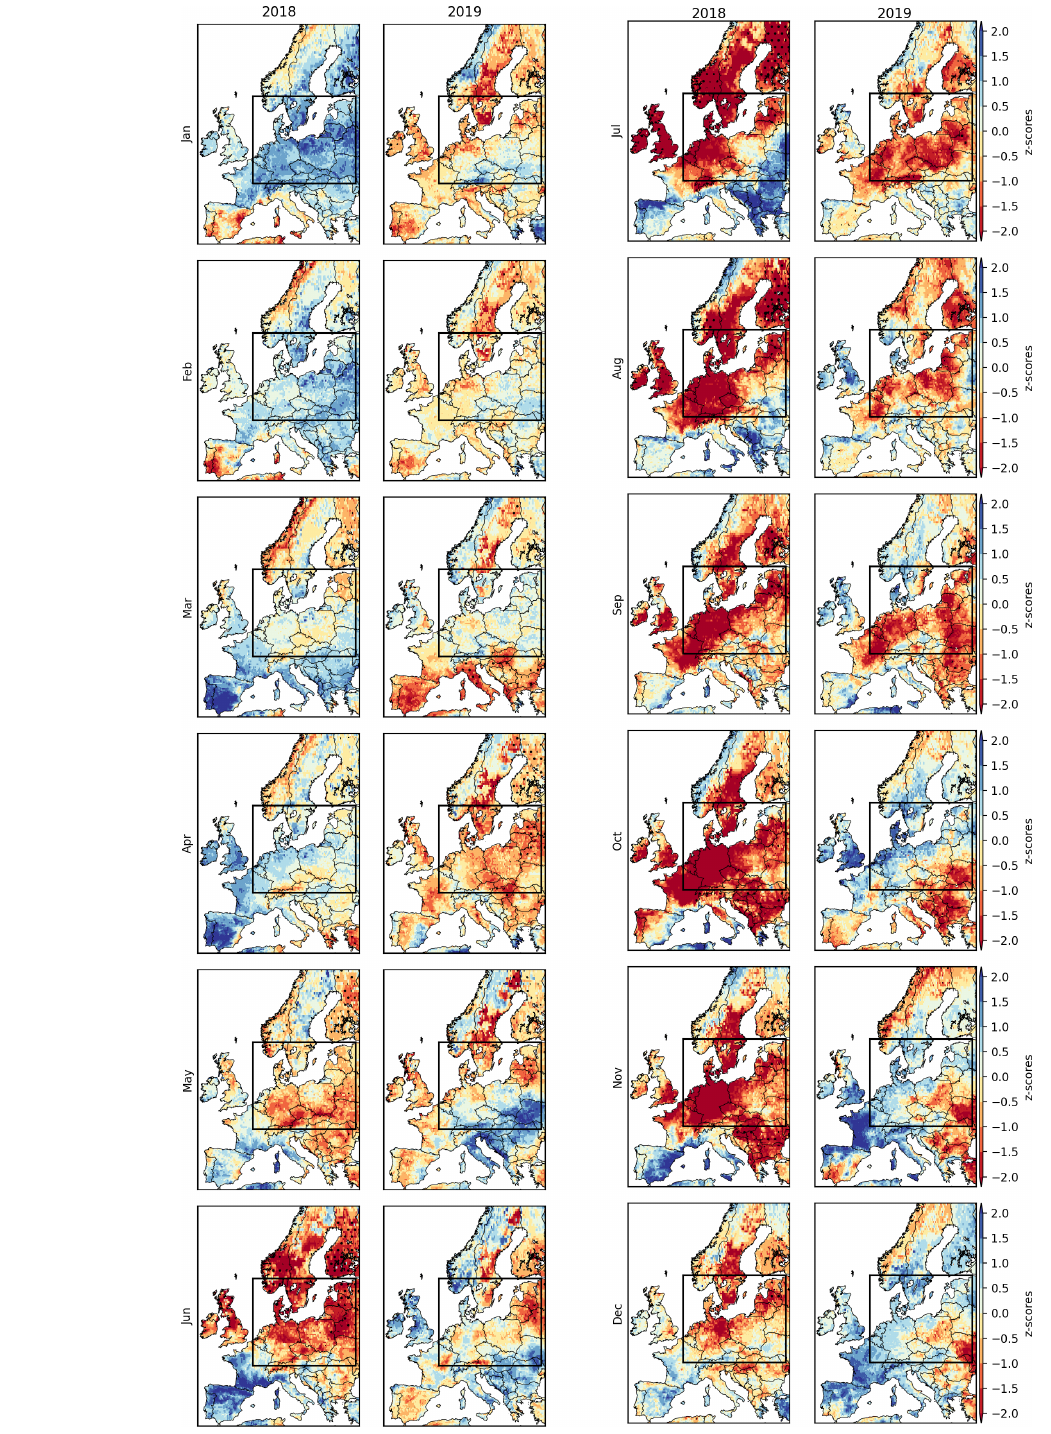
Figure B2. Monthly soil moisture anomalies during 2018 and 2019. The rectangle indicates the study region, i.e. the areas experiencing drought conditions (SM anom < − 1 σ ) during both DH18 and